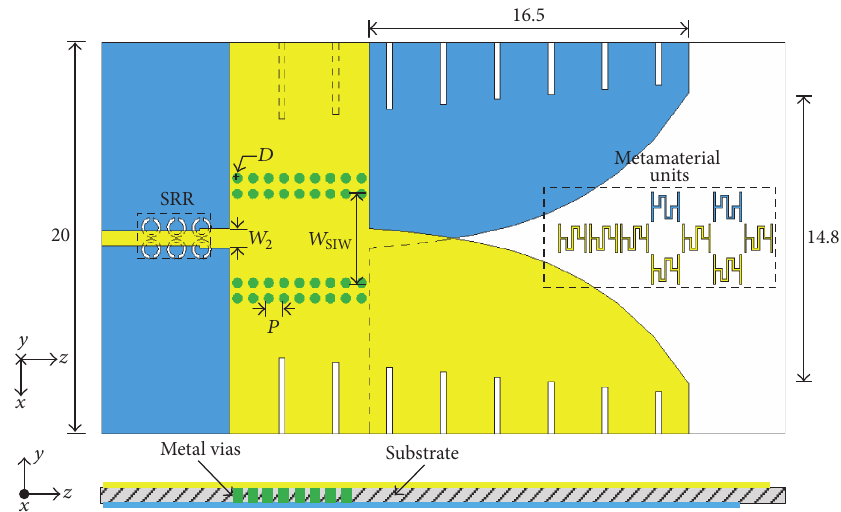
Figure 8: Structure of receiving antenna (units: mm).